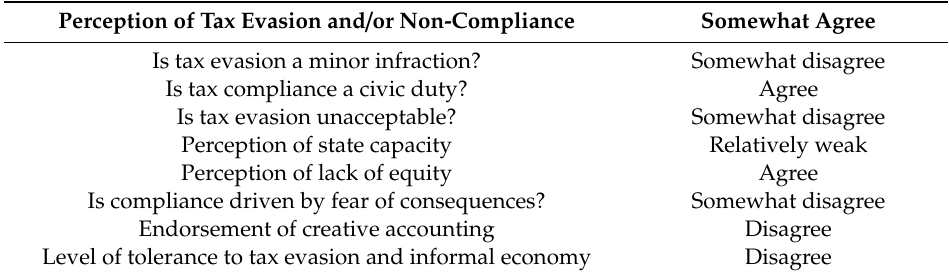
Table 1. Summary of questionnaire answers. The first three variables show the median result obtained from a five-point Likert scale questionnaire. The remaining six variables show the median response of a five-point Likert scale questionnaire in the case of latent constructs obtained using factor